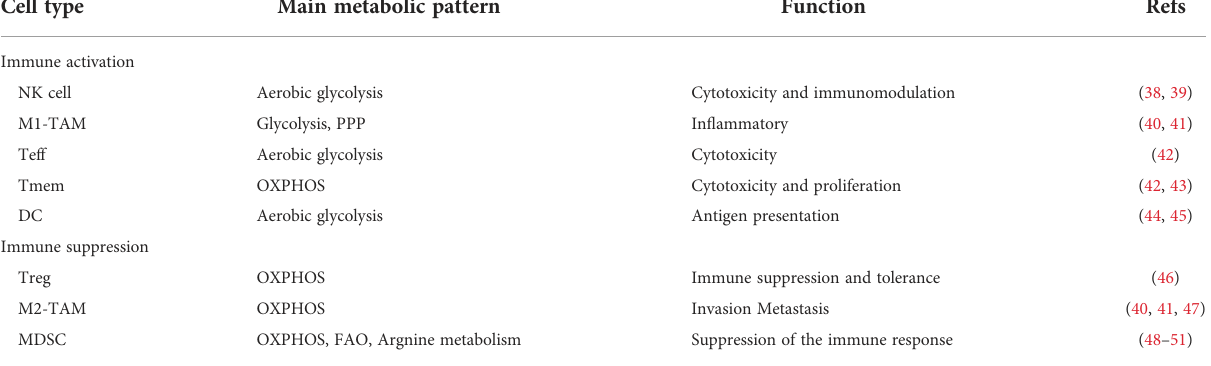
TABLE 1 Main metabolic tendencies of immune cells in ovarian